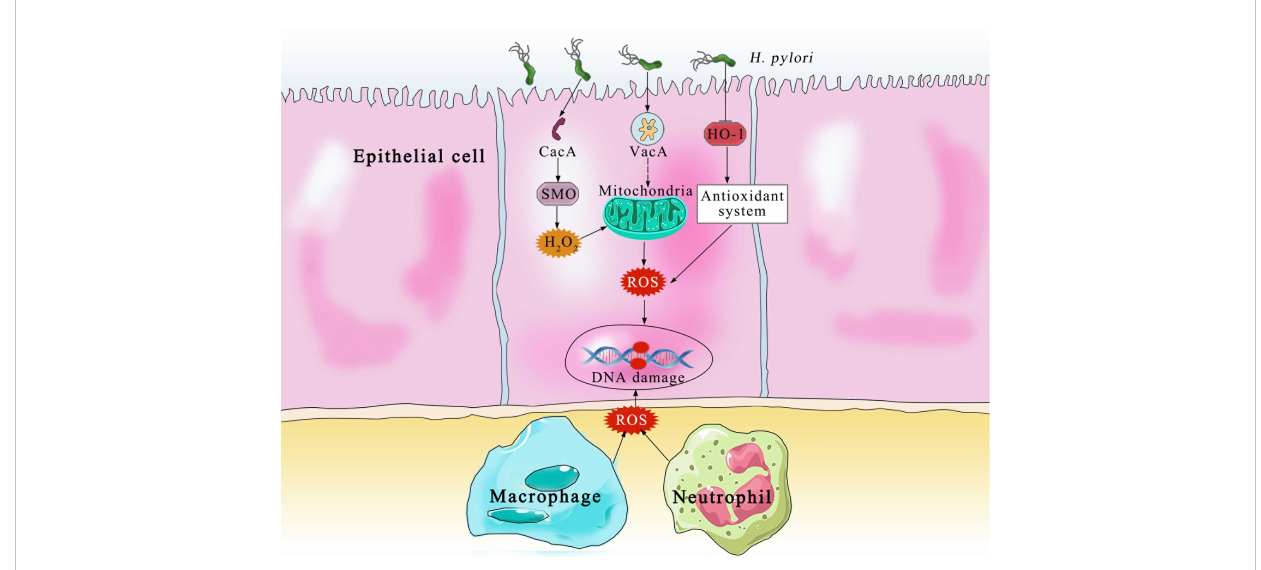
FIGURE 3 ROS and its pathophysiological effects in gastric carcinogenesis. At low to moderate concentrations, ROS function as signaling molecules that support cellular differentiation and proliferation and activate survival pathways in response to stress. Excessive ROS harms lipids, proteins, and DNA, causing mucosal injury and trigger carcinogenesis. Reactive aldehydes include 4-hydroxynonenal and other aldehydes (68). The mutator phenotype is shown by the self-directed arrow at mutation